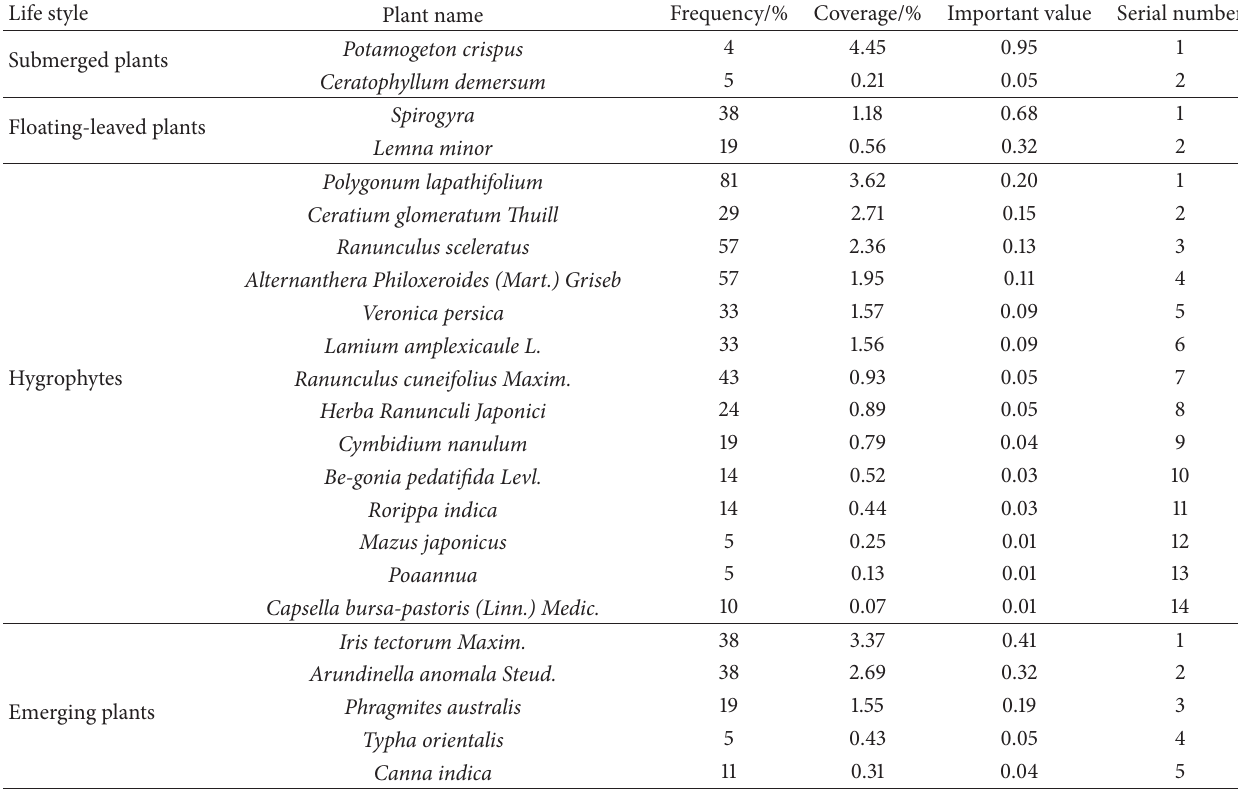
Table 2: Suburban aquatic plants quantitative